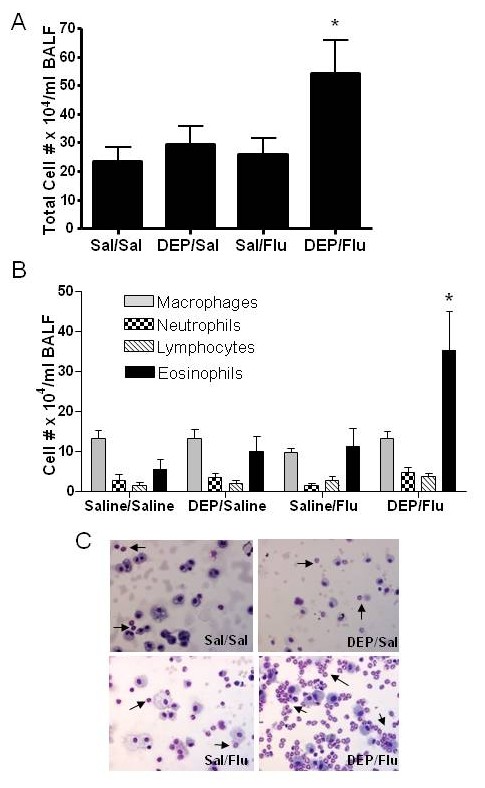
Exposure to DEP prior to infection with influenza increases BALF eosinophils levels in OVA-sensitized mice. A.) Total and B.) differential cell count of BAL fluid from OVA-sensitized mice exposed to DEP and/or infected with influenza A. C.) Representative images of BALF cells in obtained from the different experimental groups. *significantly different from Sal/Sal control; p < 0.05.